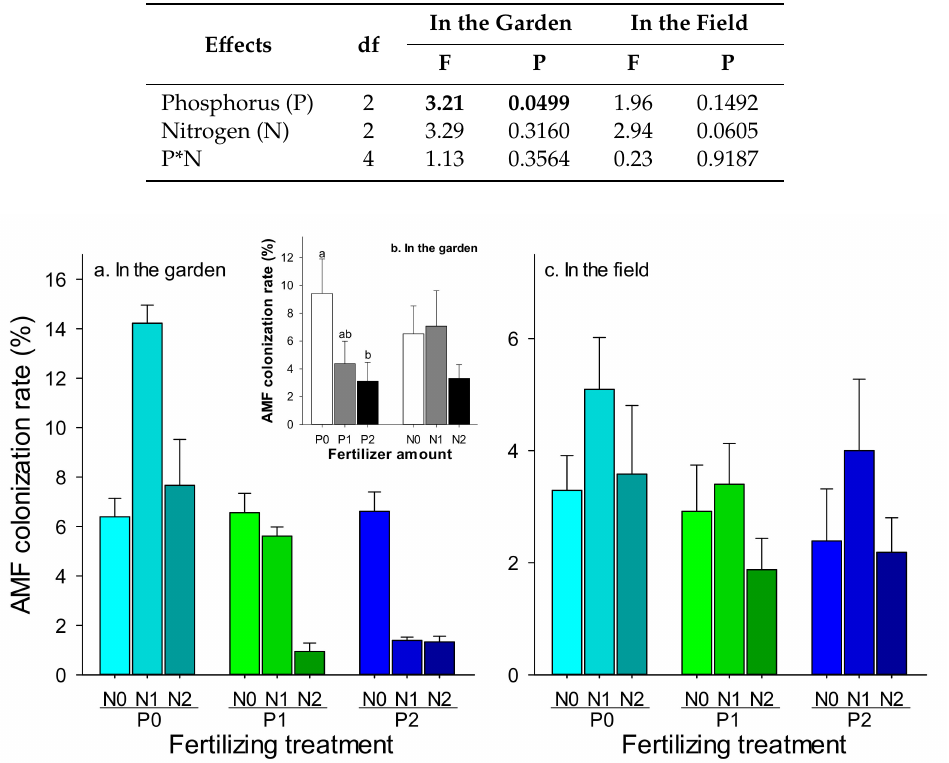
Figure 2. The e ff ect of di ff erent combinations (amounts) of phosphorus (P) and nitrogen (N) fertilization on the AMF colonization rate of wheat roots in the garden and the field. ( a ) The e ff ect of combinations of P and N Fertilization, ( b ) the e ff ect of di ff erent amount of P or N based on the two-way analysis of variance (ANOVA) that indicated there was no interaction between P and N, ( c ) the e ff ect of combinations of P and N Fertilization in field. The bars are the means with SE. Bars with di ff erent letters indicate significant di ff erences based on one-way ANOVA at p <